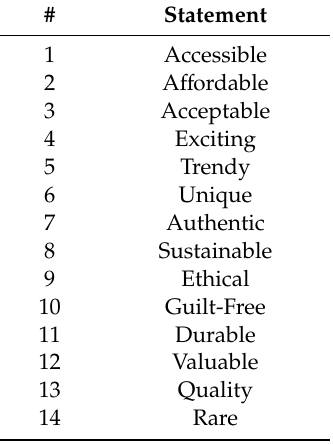
Table 1. Q Sample Statements for Fast Fashion and Second-Hand Clothing Q